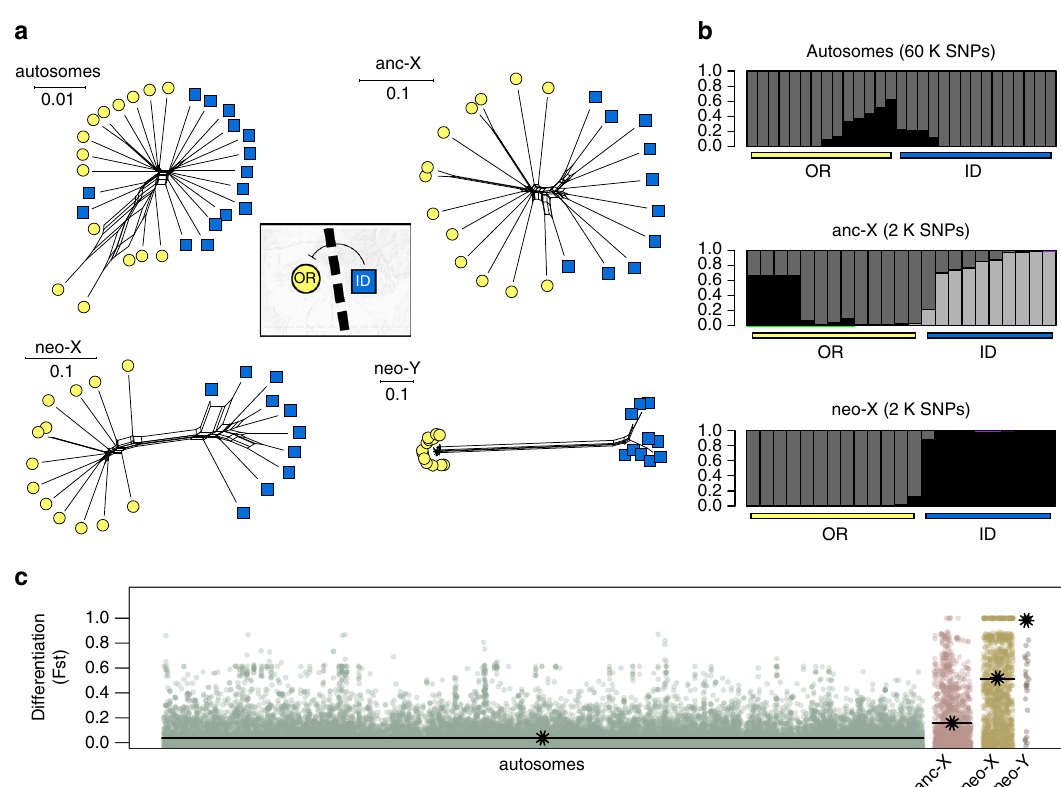
Fig. 3 Genomic variation near the boundary of reproductive isolation. a Phylogenetic networks (autosomes = 40,195 SNPs; anc-X = 1853; neo-X = 1525; neo-Y = 203) from populations closest to the boundary of reproductive isolation (OR and ID). b Results from STRUCTURE analyses of SNPs from three linkage categories. Autosomal analyses include both males and females while anc-X and neo-X analyses included just males. Shown is the posterior probability of assignment to a cluster ( K ) and K = 2 for the autosomes ( K = 1 was best supported), and what was identi fi ed as the best K for the anc-X (3) and neo-X (2). c Pairwise genetic differentiation ( F st ) along concatenated scaffolds for each partition (bar and asterisk = global weighted